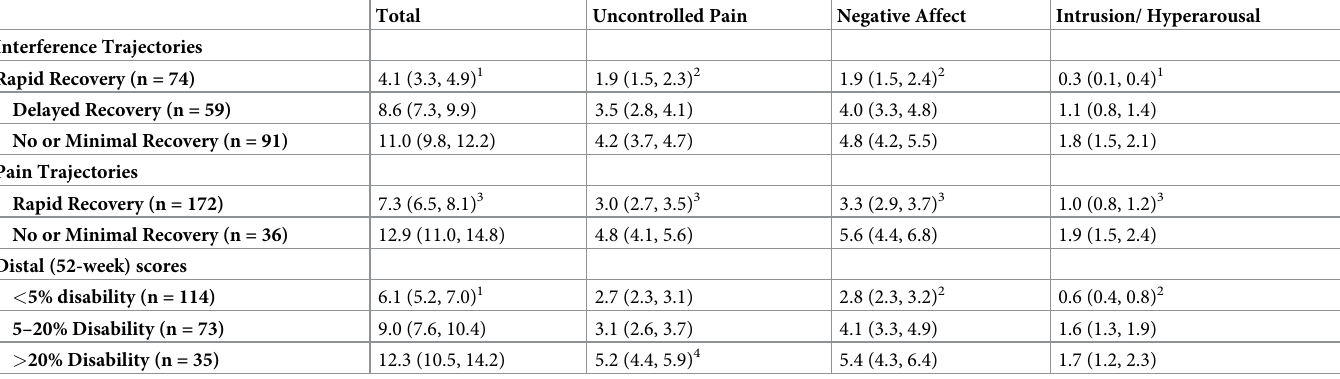
Table 3. Group means and 95% confidence intervals for TIDS total score and 3 subscales compared across levels of recovery trajectory ( < 3 weeks to 12 months) or cross-sectional 12-month distal